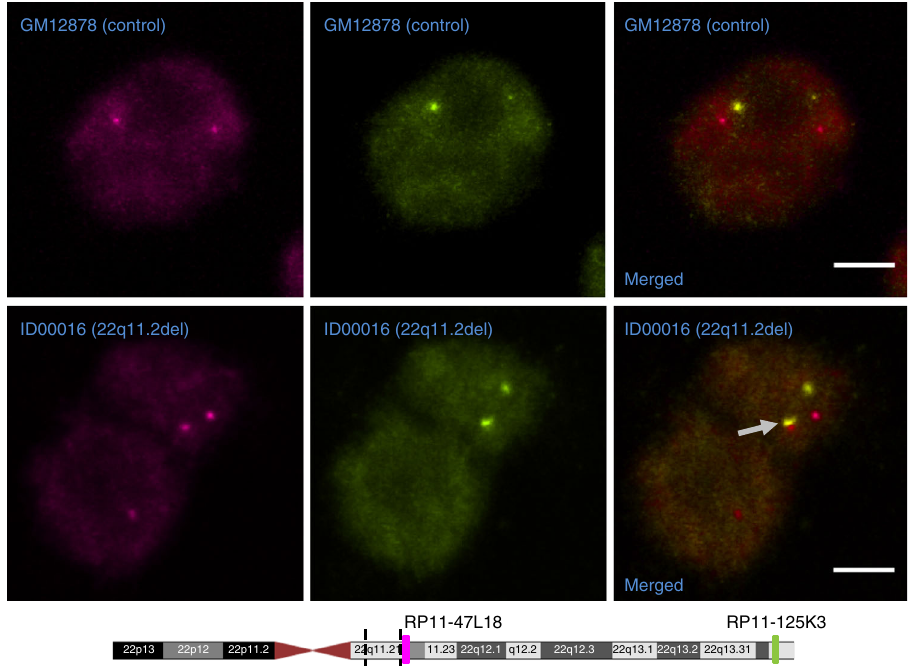
Fig. 5 Examples of 3D FISH visualization of intra-chromosomal interaction changes. The regions for which Hi-C predicted changes in interaction, regions 21.8 – 22.5 and 50 – 51 Mbp on chromosome 22q, were visualized by 3D DNA FISH using BAC probes RP11-47L18 and RP11-125K3, labeled with biotin (magenta) or digoxigenin (green). Arrow: an example for the magenta and green FISH probes in close proximity in a cell carrying the 22q11.2 deletion. Scale bars are 5 µ m. Magenta and green bars on chromosome 22q indicate the locations of the biotin and digoxigenin FISH probes, respectively. Black dashed lines indicate the position of the 3-Mbp